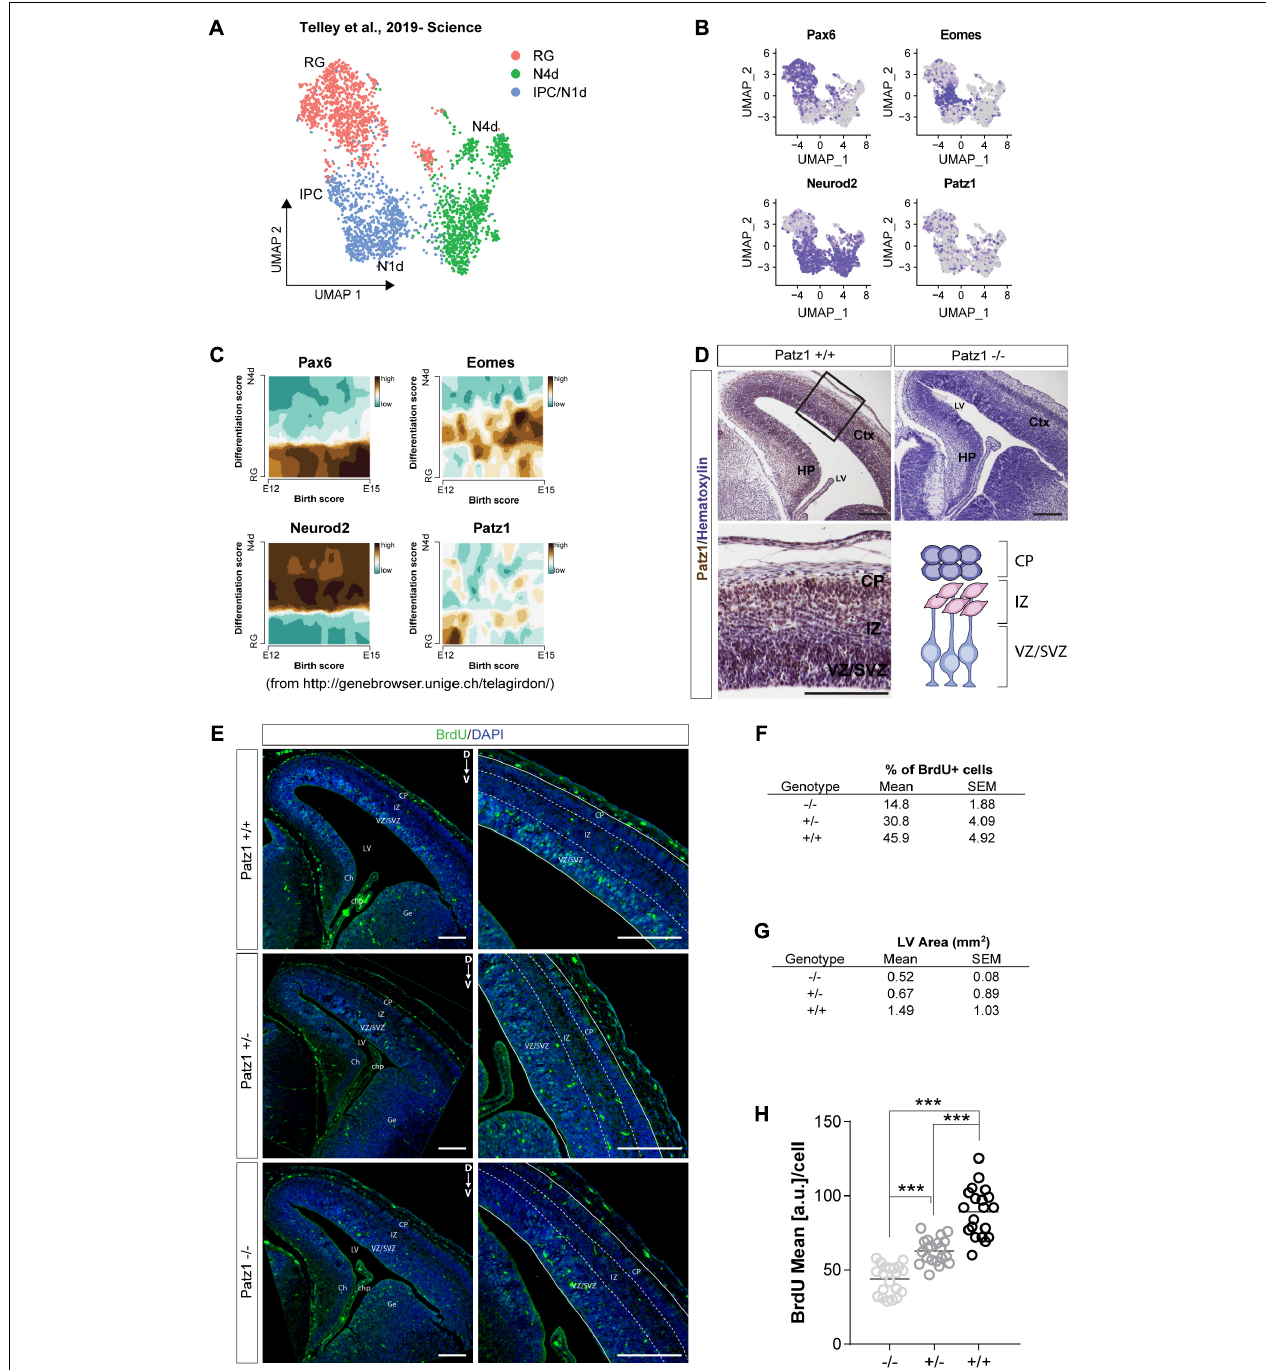
FIGURE 3 | Analysis of Patz1 expression dynamic in cortical progenitors and incorporated BrdU assay in Patz1 -knockout embryonic VZ-SVZ. (A) UMAP showing cellular composition of the dataset of Telley et al. (2019), including presumptive somato-sensory cortex of E12, E13, E14, and E15 mouse embryos. (B) Feature Plots of selected progenitors and neuronal markers. (C) Trajectory plots showing the correlation between differentiation score and age (developmental stage) of selected genes. (D) Representative images and relative higher magnification of mouse embryonic brain coronal section (E15.5) immunolabeled with Patz1. (E) Representative images and relative higher magnification of BrdU immunological detection in brain coronal sections of wild type (wt) and Patz1 mutant E15.5 embryos. Proliferating cells appear as light blue, due to overlapping of blue (DAPI) and green (BrdU) colors. (F,G) Tables showing the percentage of BrdU + cells in the VZ/SVZ (F) and lateral ventricle area (G) according to genotype. (H) Dot Plot showing the BrdU mean intensity level per cell in the different genotypes. The significant differences are indicated by asterisks. ∗∗∗ P < 0.001, as assessed by ANOVA followed by Tukey’s multiple comparisons test. Scale bars: 100 µ m. RG, radial glia, IPC, intermediate progenitors; N1d, 1 day old Neurons; N4d; 2 days old neurons; CP, Cortical Plate; IZ, intermediate zone; VZ/SVZ; ventricular zone/subventricular zone; LV, lateral ventricle, Ch, cortical hem; Chp; choroid plexus; Ge; ganglionic eminence.